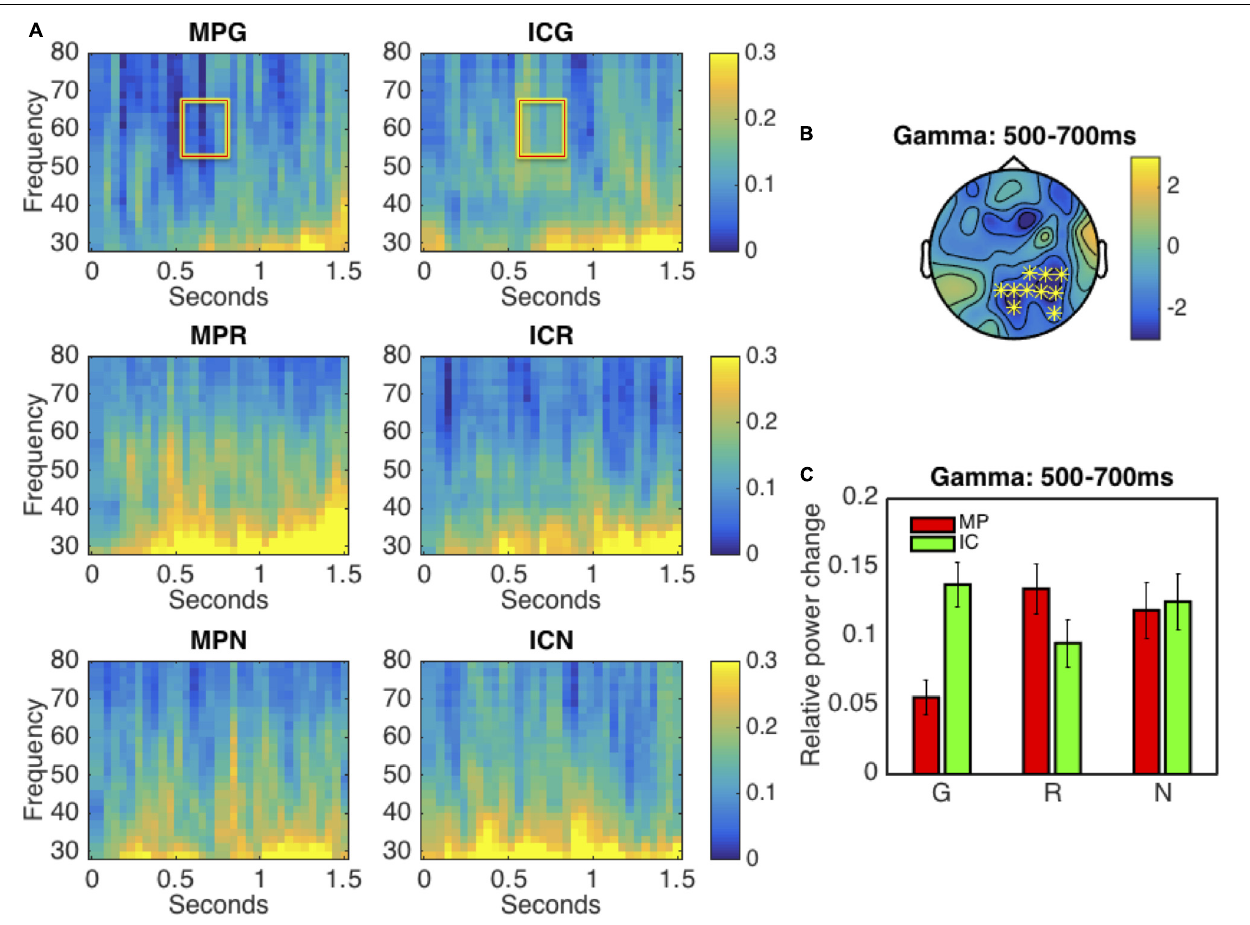
FIGURE 2 | Results of the time-frequency (TF) analysis. (A) The panel shows the TF representations of all conditions at electrode P4. (B) This panel illustrates the scalp distribution of the significant cluster in the gamma band (50–70 Hz) in the 500–700 ms interval. The electrodes forming the significant cluster are marked with asterisks on the topographic plot. Panel (C) shows the averaged (across trials and subjects) relative power changes in the gamma band (50–70 Hz) for all experimental conditions in the 0.5–0.7 s time interval at all electrodes in the significant cluster (as in panel B